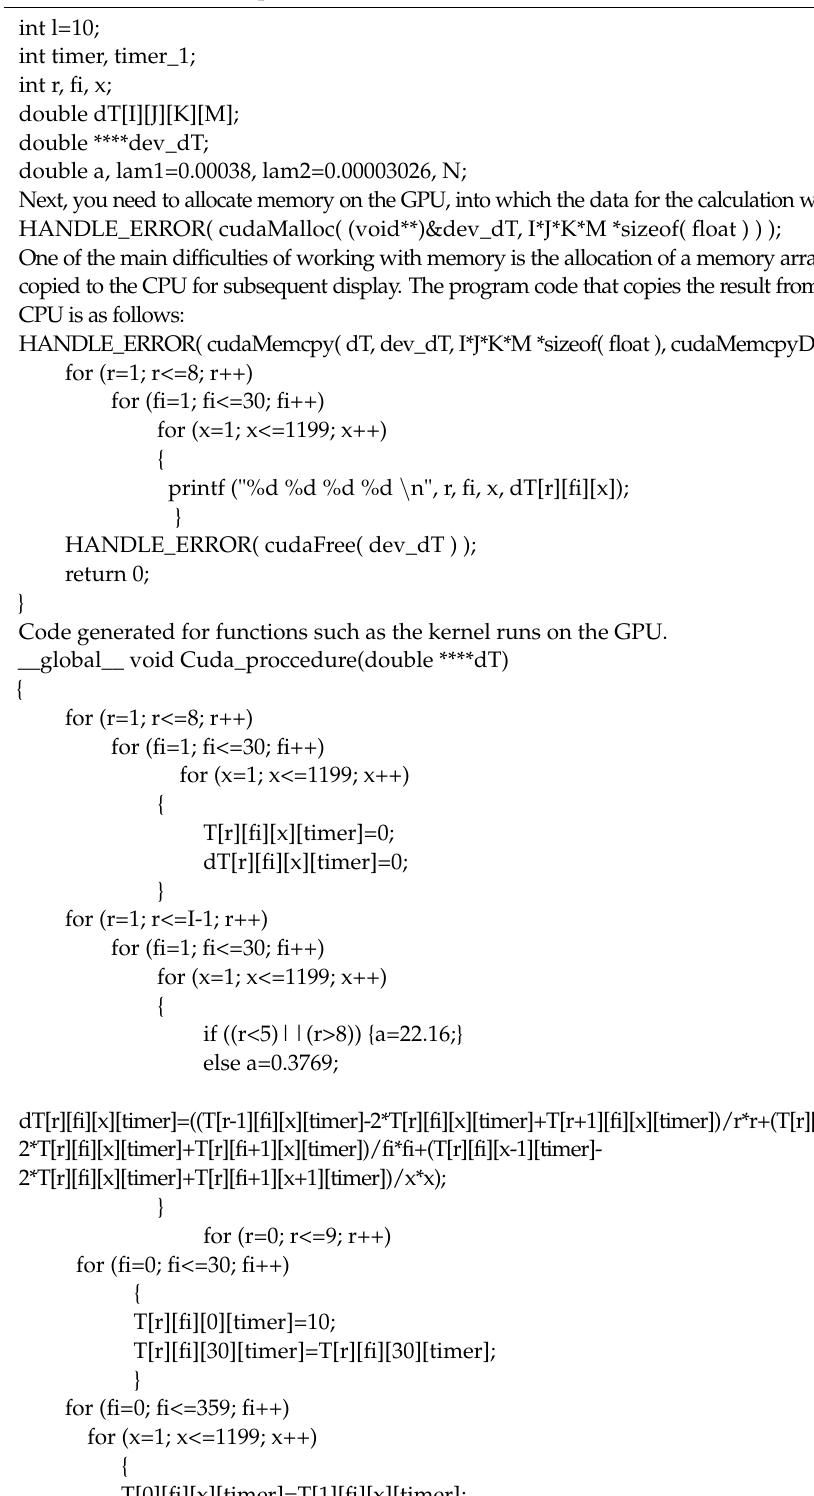
Algorithm 1. Fields temperature